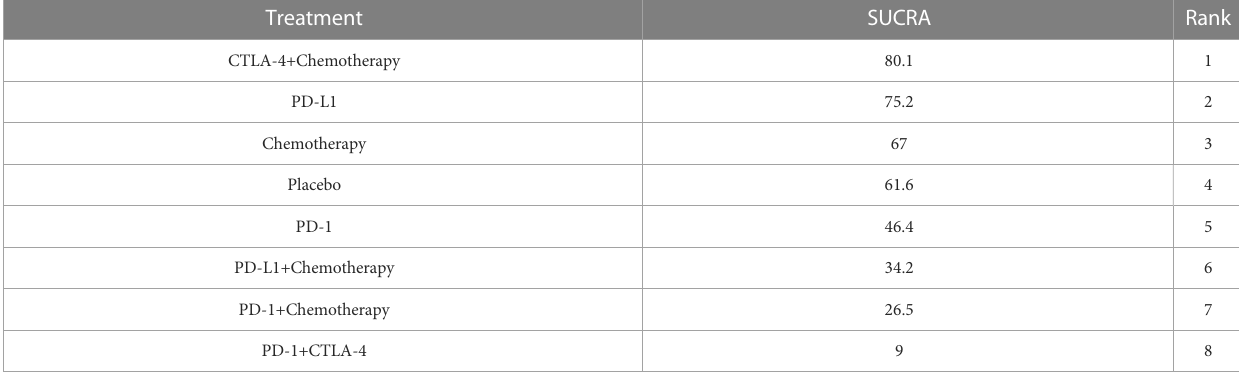
TABLE 2 SUCRA ranking probabilities of different treatments.